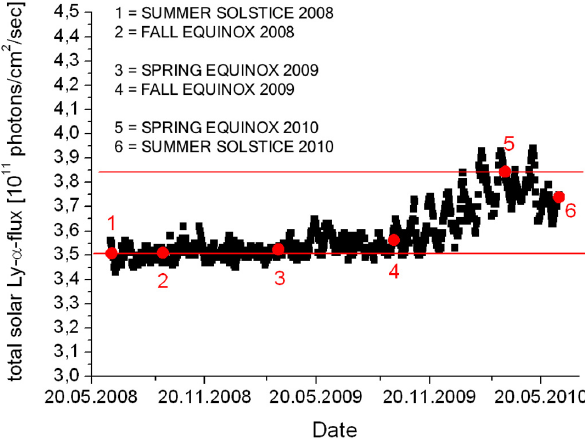
Fig. 6. The composite, total solar Lyman- α flux taken from TIMED SEE and SORCE SOLSTICE which shows low flux values and low variability until end of 2009 followed by a 10% increase un- til June 2010. Red points mark the dates which are included in the model fit. The 27 day period of solar activity is also visible as small periodic